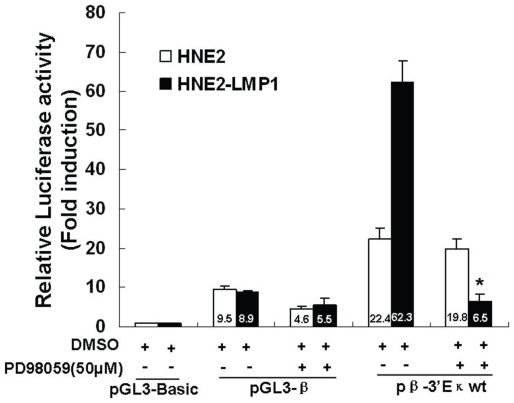
The MEK inhibitor, PD98059, abolishes the LMP1-increased 3′Eκ enhancer activity.HNE2 and HNE2-LMP1 cells were co-transfected with pβ-3′Eκwt, pGL3-β, or pGL3-Basic and the internal control pRL-SV40 plasmids. Cells were incubated for 24 hr and then treated with PD98059 (50 µM) or DMSO (0.1%) for an additional 12 hr after which activity of firefly and Renilla luciferase was monitored as described in “Materials and Methods”. Values for firefly luciferase activity were normalized to those obtained for Renilla luciferase activity. Values obtained for pβ-3′Eκwt- or pGL3-β-transfected cells were divided by the corresponding values obtained for pGL3-Basic-transfected cells. Data are shown as means ± S.D. of three independent experiments performed in triplicate. Statistical significance: *p<0.05.